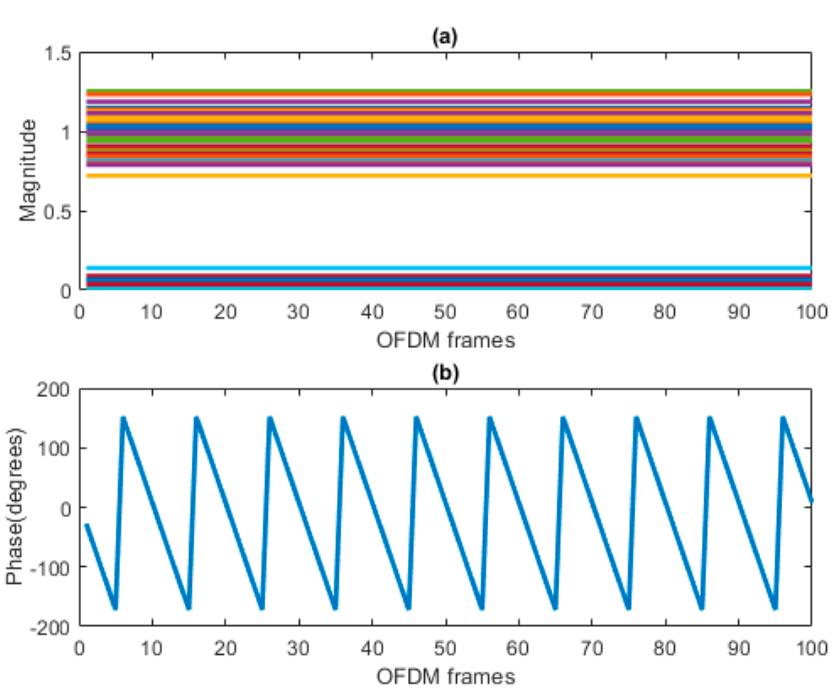
Figure 8. Dispersive channel response ( a ) magnitude; ( b ) phase.